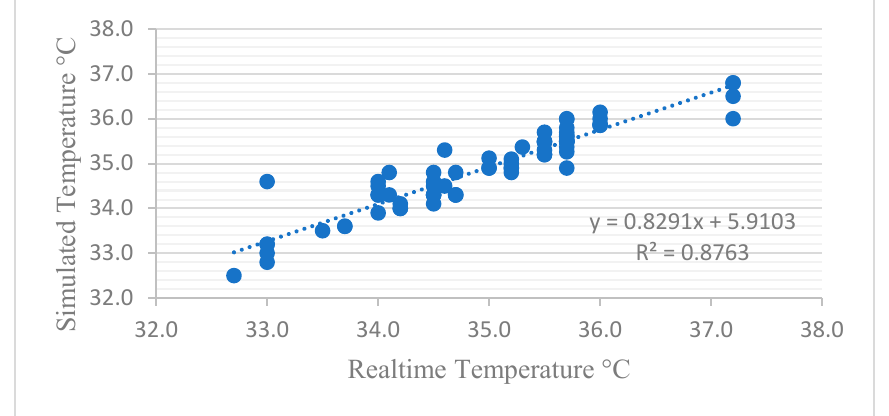
Figure 4. Regression graph for the sample classrooms.